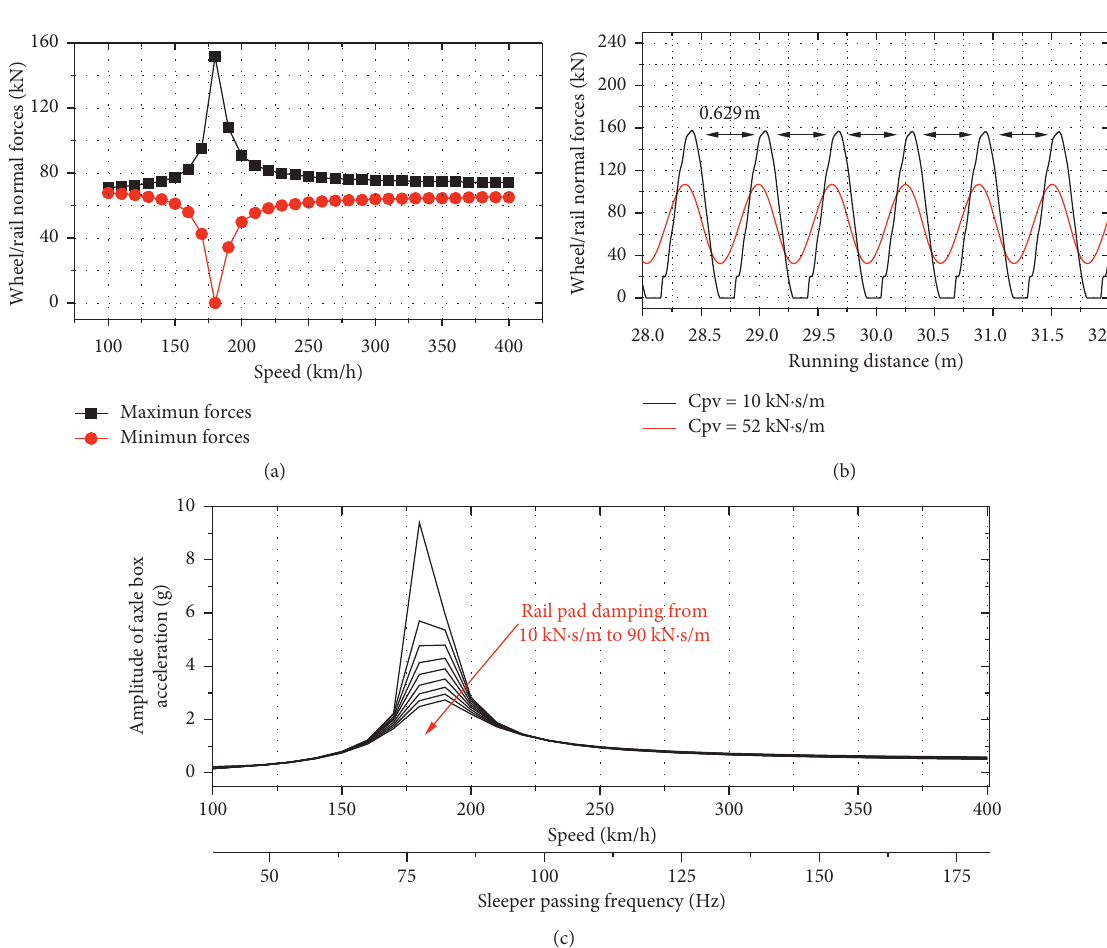
Figure 13: Wheel/rail normal forces and axle box accelerations due to sleeper passing impacts: (a) maxima and minima of wheel/rail normal forces obtained at different vehicle speeds ( K pv � 200MN/m and C pv � 10kN s/m); (b) comparison of the wheel/rail normal forces for rail pad damping 52 kNs/m and 10kNs/m; (c) effects of rail pad damping on the axle box